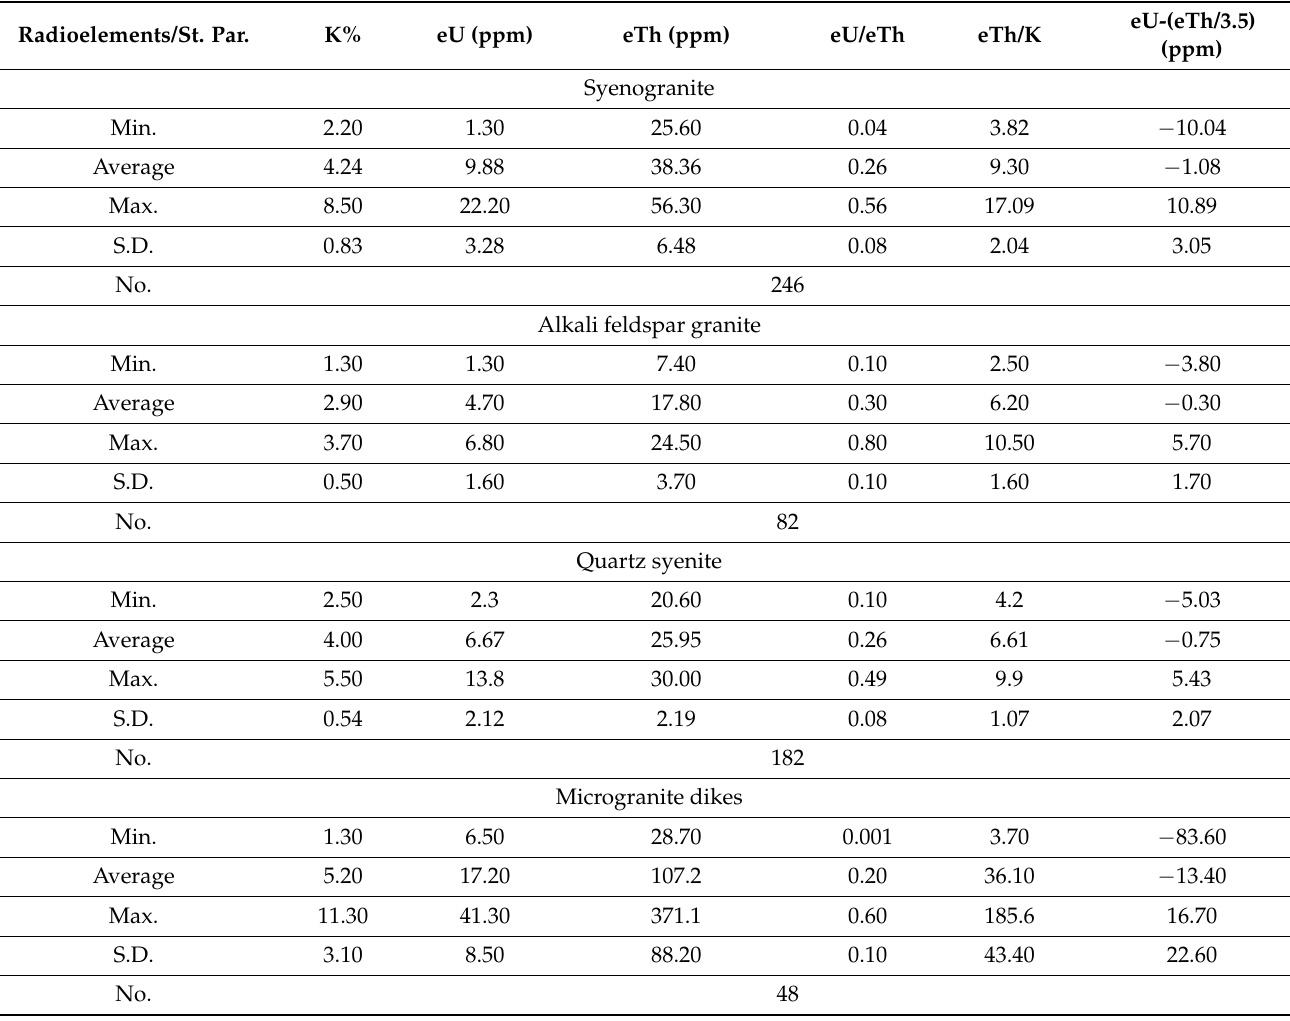
Table 1. Summary of the statistics of the surface distribution of the three radioelement potassium percentages, equivalent uranium and equivalent thorium (K%, eU (ppm), eTh (ppm), respectively) and their ratios at Nikeiba, Southeastern Desert,